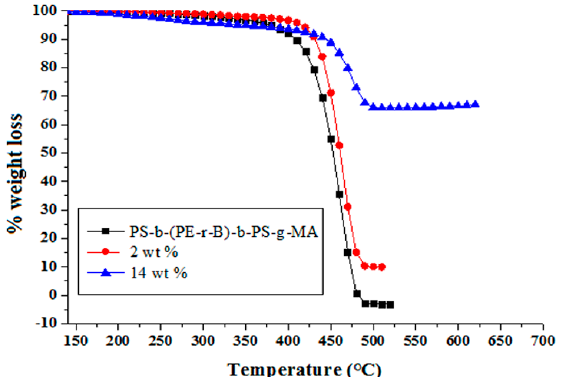
Figure 11. Thermogravimetric analysis (TGA) thermograms of neat PS- b -(PE- r -B)- b -PS- g -MA and composites with 2 wt % and 14 wt % Cu–Al 2 O 3 loading.